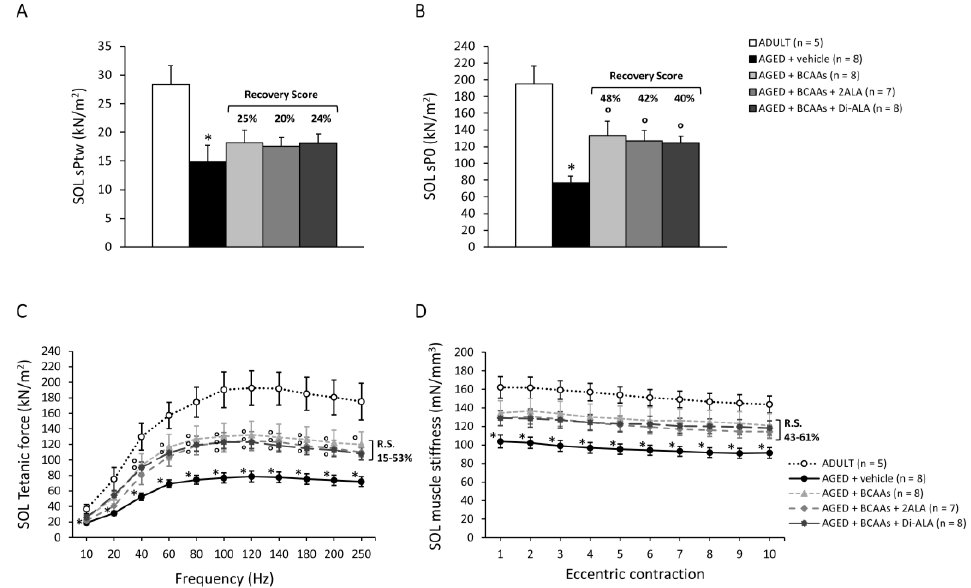
Figure 4. Maximal specific isometric twitch ( A , sPtw; kN/m 2 ) and tetanic ( B , sP0; kN/m 2 ) force, tetanus–frequency curve produced at increasing frequencies (10–250 Hz, C ; kN/m 2 ), and elastic properties in response to a series of 10 eccentric pulses ( D , stiffness; mN/mm 3 ) measured in SOL muscles isolated from ADULT mice and AGED mice treated with vehicle, BCAAs, BCAAs + 2ALA or BCAAs + Di-ALA. All values are expressed as mean ± SEM for the number of mice indicated in brackets. For all parameters, a statistically significant difference was found via an unpaired Student’s t -test for AGED + vehicle vs. ADULT mice (*; 0.0001 < p < 0.01). A statistically significant difference among AGED mice groups was found via a one-way ANOVA for sP0 (F = 4.8, p = 0.008) and for tetanus – frequency curve at 40 Hz and higher (F > 3.3, p < 0.04). Dunnett’s post hoc test, used to compare each mixture-treated group to the vehicle group, is as follows: ° vs. AGED + vehicle (0.006 < p < 0.05). The recovery scores (R.S.) towards ADULT values, calculated for each treated group, are indicated above the bars in ( A , B ) or at the right end of the lines in ( C , D ).